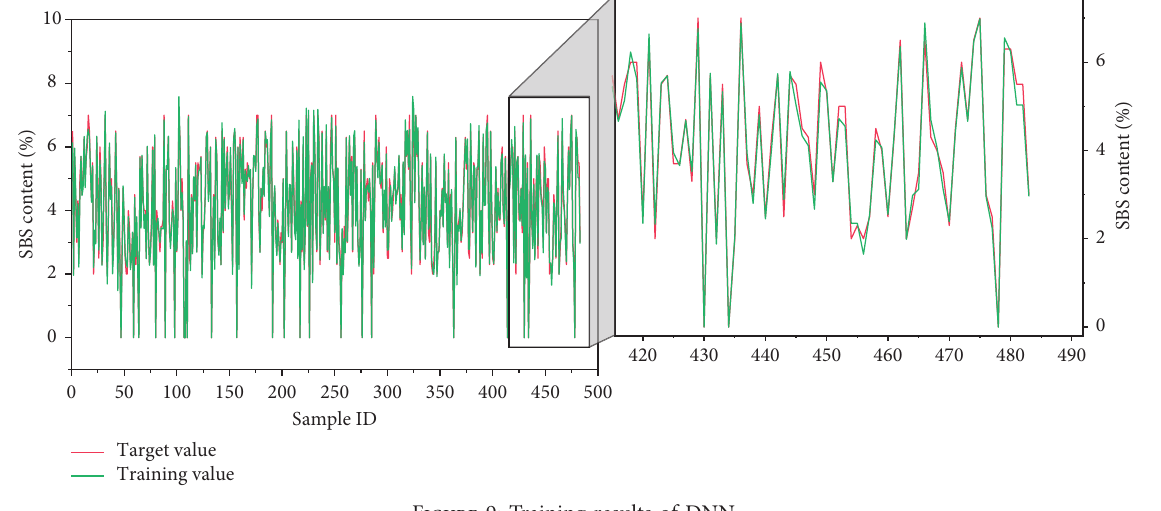
Figure 9: Training results of DNN.